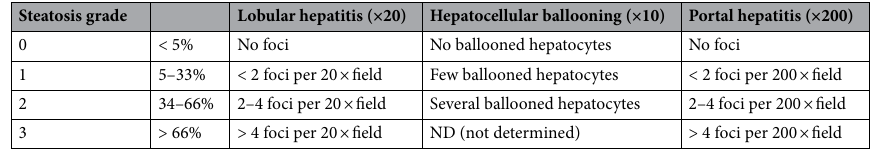
Table 3. NASH scoring